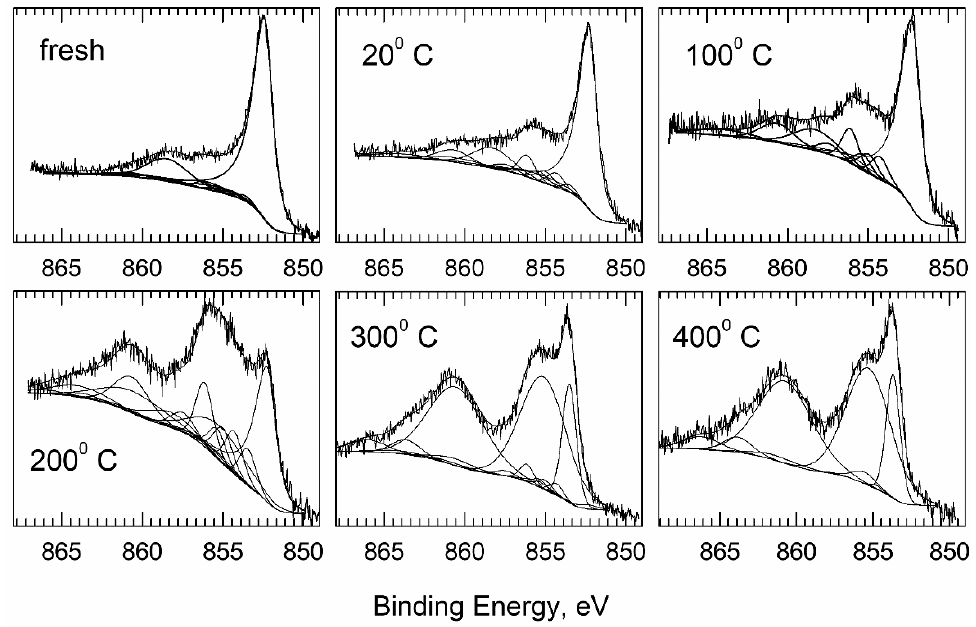
Figure 6. XPS Ni 2p 3/2 spectra of the samples with deconvolution indicating the components: Ni(0), NiO, NiOOH and Ni(OH) 2 .